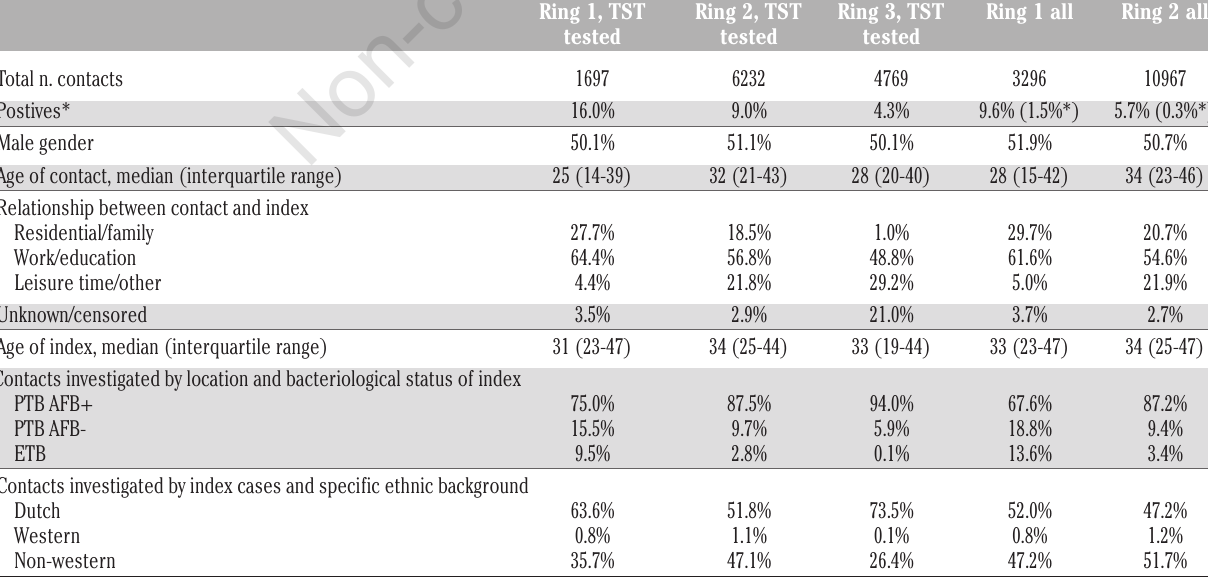
Table 1. Characteristics of the contacts included in the source tracing and contact investigations 2001-2006 performed by the Municipal Public Health Service Rotterdam-Rijnmond, the Netherlands. Contacts are stratified by ring according to a concentric cir- cle approach, as specified in the national guidelines for contact investigations in the Netherlands. Ring 1 contains close contacts, ring 2 contains regular contacts, while ring 3 contains community